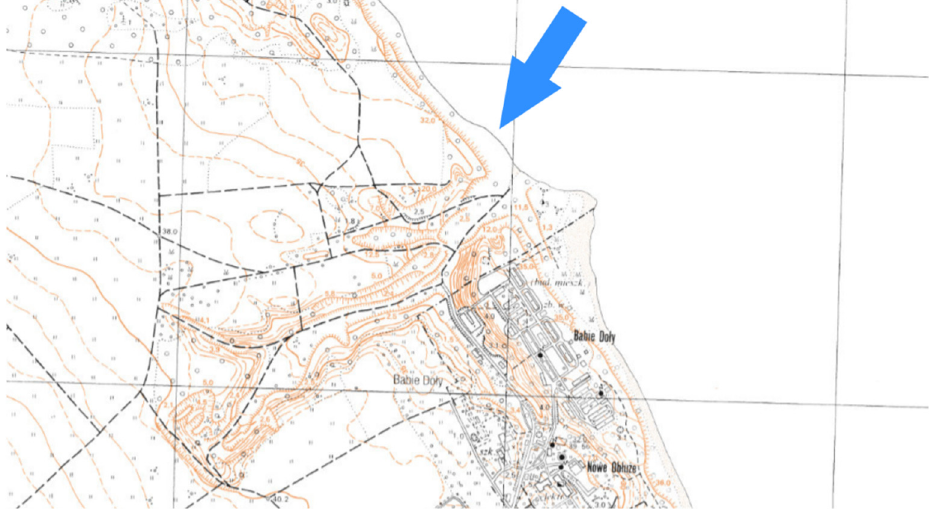
Figure 9. The analysed section of coastline on the map from 1965 (1:10,000). The blue arrow indicates the approximate location of KM 93.6–93.9.